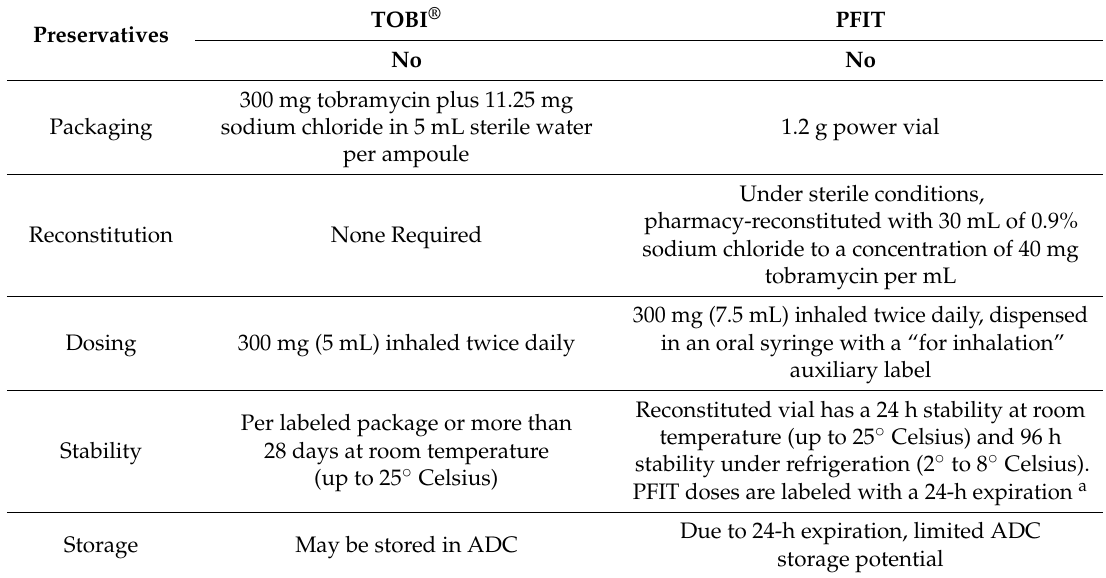
Table 1. Comparison of TOBI ® and PFIT, inhaled tobramycin products [3,4].